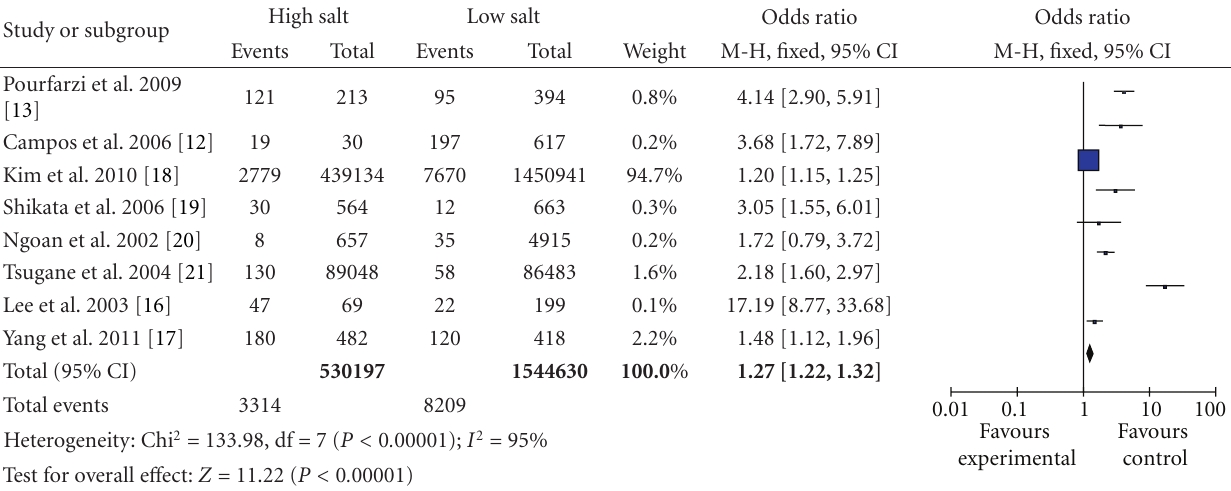
Table 5: High versus low categories of salt and gastric cancer in